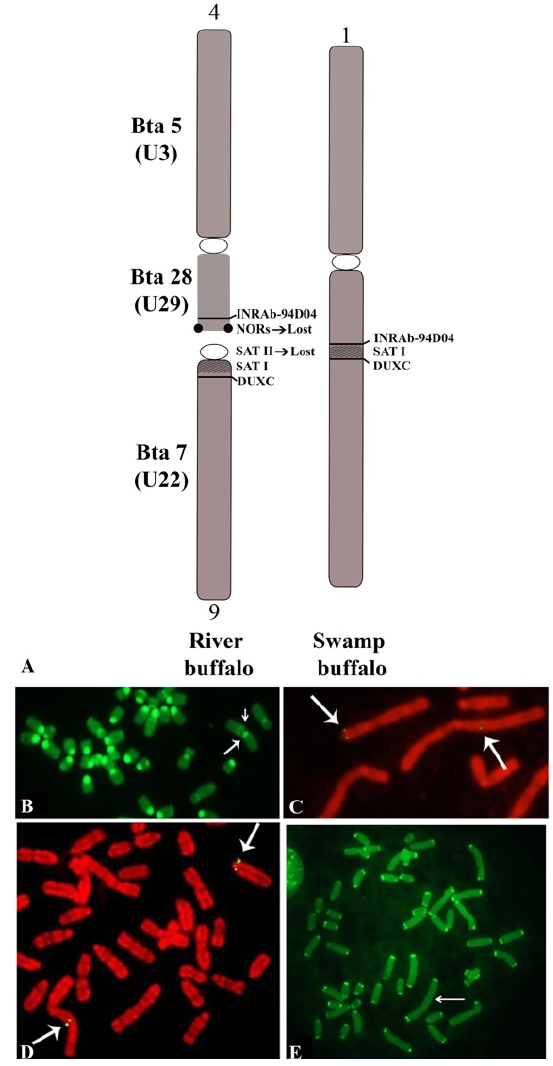
Figure 3. ( A ) Schematic representation of tandem fusion translocation between river buffalo chromosomes 4p (telomere) and 9 (centromere) in the origin of swamp buffalo chromosome 1. Both NORs available in BBU4p telomeres and SAT-II sequences available at the centromere of BBU9 were lost during the tandem fusion. Only the SAT-I sequences were partially conserved during the fusion. Moreover, homologous cattle chromosomes and relative syntenic groups are reported on the left of BBU4 and BBU9. ( B ) Details of CBA banding in a male metaphase plate of a hybrid river swamp buffalo. Note a large positive C-band at the centromere of swamp buffalo chromosome 1 (large arrow) and a pale and proximal positive C-band (small arrow), which are probably part of the SAT-I sequences of BBU9 conserved during the fusion. ( C ) Details of a metaphase plate of hybrid river– swamp buffaloes showing the result of the FISH mapping, with the marker INRAb_94D present both at the telomeres of BBU4 and the fusion point of swamp buffalo chromosome 1 (arrows). ( D ) Details of a metaphase plate of hybrid river–swamp buffalo showing the result of the FISH mapping, with the marker DUXC present at both the pericentromeric region of BBU9 and the fusion point of swamp buffalo chromosome 1 (arrow). ( E ) River–swamp buffalo hybrid metaphase showing the result of FISH mapping with a PNA telomeric probe. Clear hybridization signals were observed only at the telomeres of all chromosomes, and absent at the fusion point in swamp buffalo chromosome 1